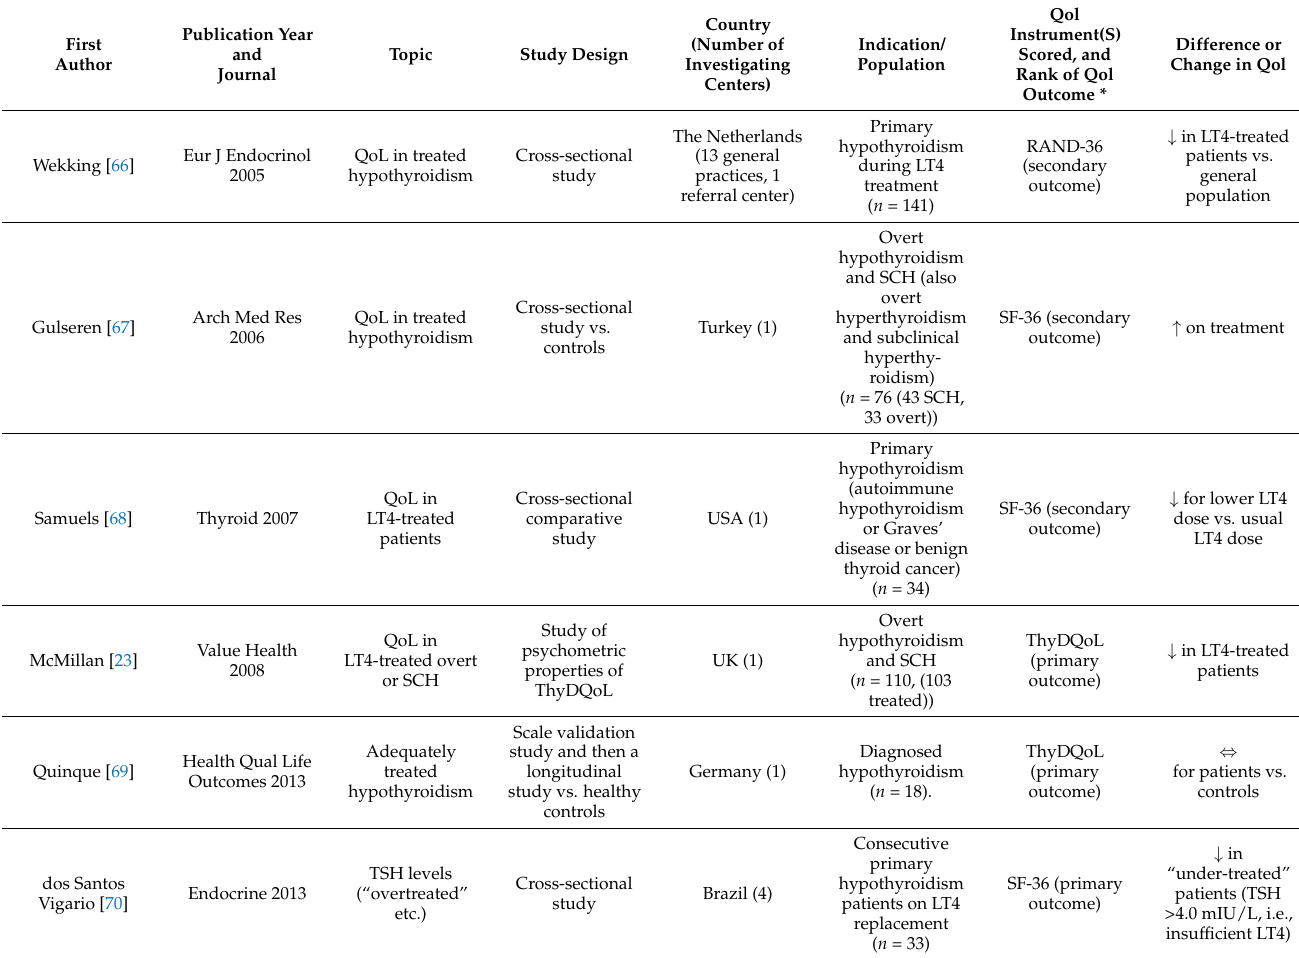
Table 3. Reviewed nonrandomized studies, by year of